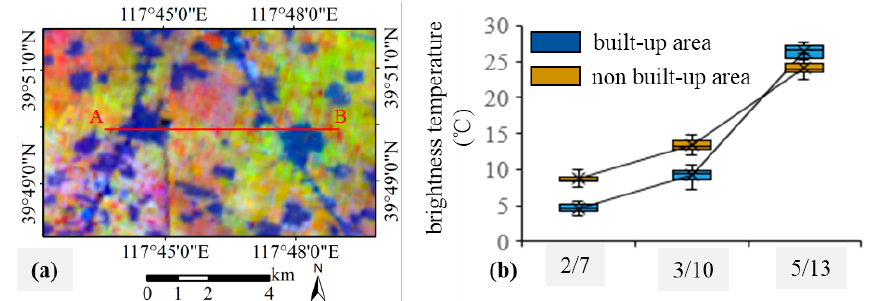
Figure 4. ( a ) The typical transect line AB comprising built-up area and other land-use types on false color composite image of three-date brightness temperature in the experimental study area; ( b ) the link-box-plot of the built-up area (blue box) and non-built-up area (yellow-brown) on transect line AB.